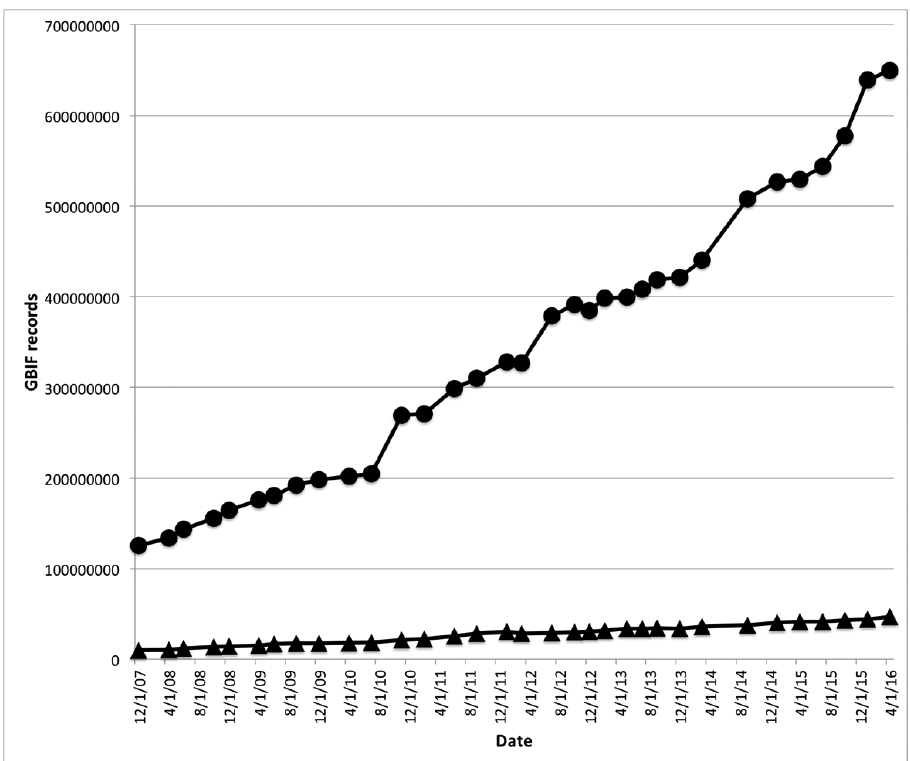
Figure 1. Number of insect records in GBIF.org (triangles) between December 2007 and March 2016, in comparison to all records